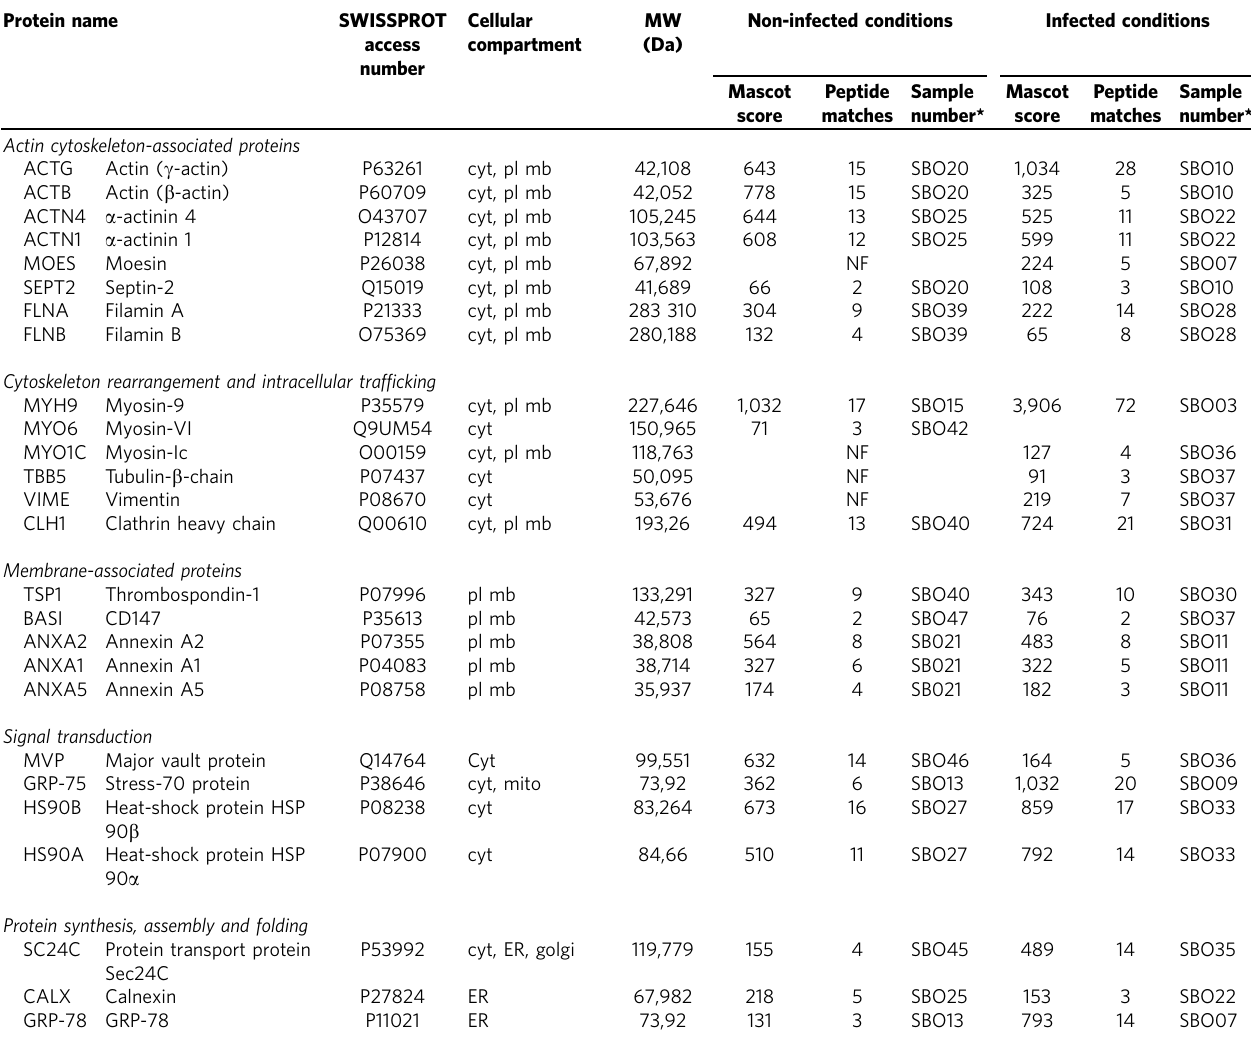
Table 1 | CD147 partners in HBMECs identified by mass spectrometry. Protein